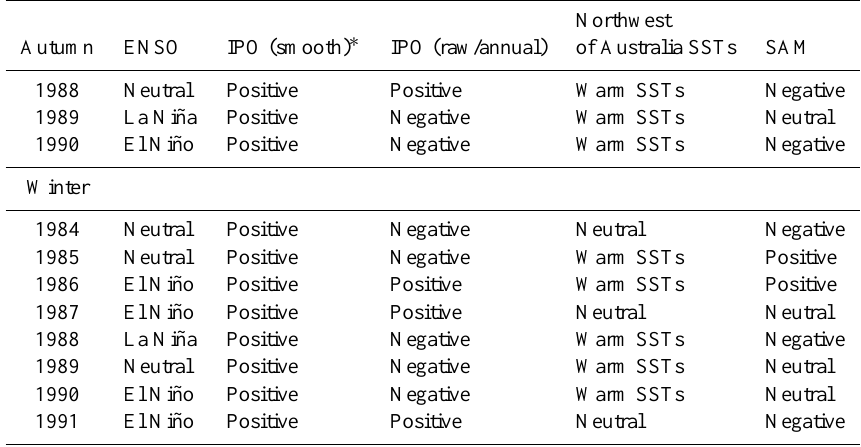
Table 3. State of large-scale drivers during “wet seasons”.